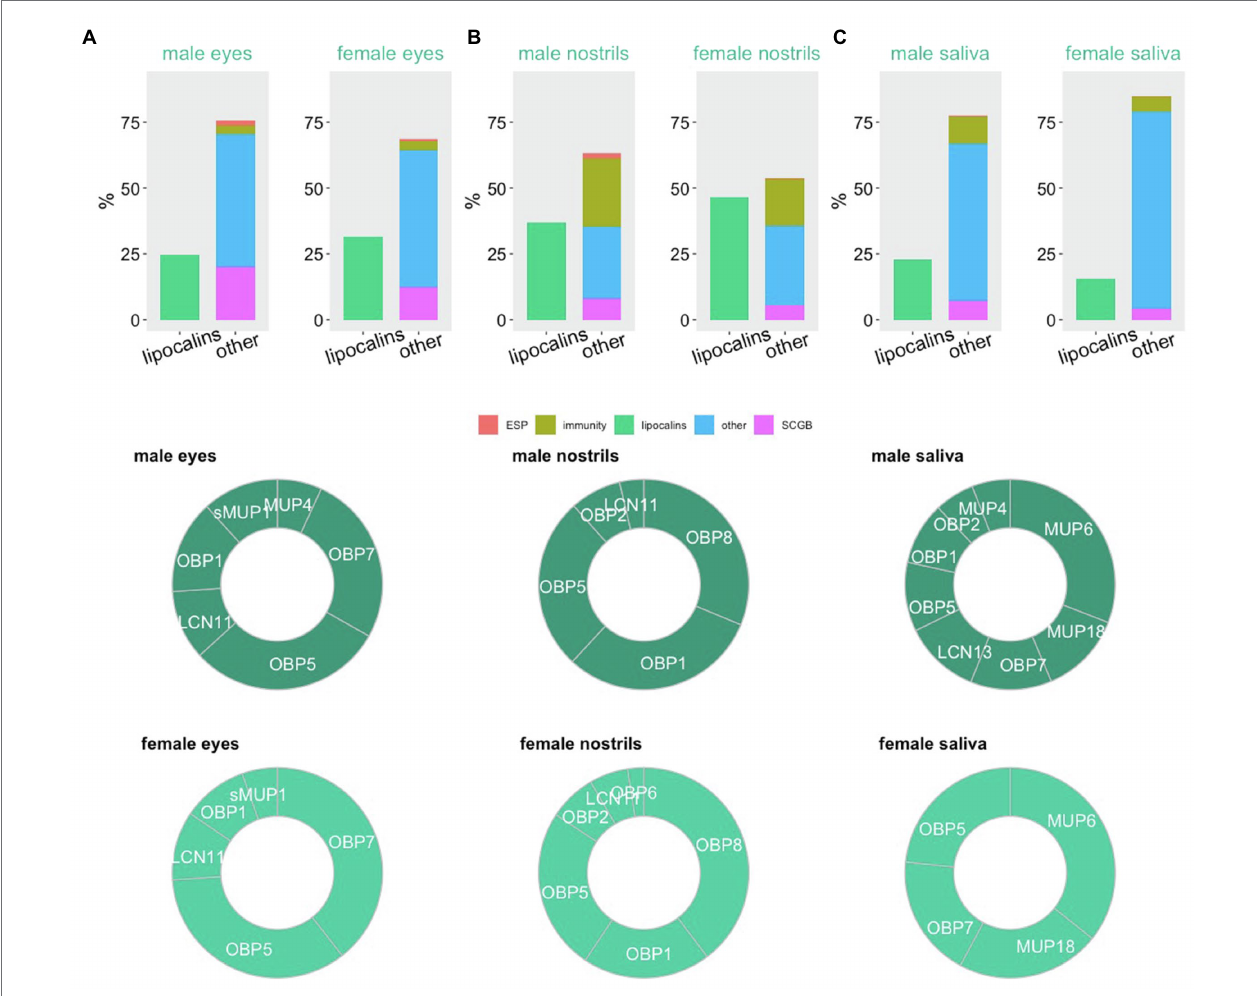
FIGURE 2 | Proteomic signatures in major orofacial secretions of the house mouse. Estimation of protein abundances is represented as a fraction (%) of all proteins in male and female eyes (A) , nostrils (B) , and oral cavity (C) . We have extracted this data from our previously published studies with publically available data. Proxy for functions (exocrine-gland secreted peptides – ESP, immunity, lipocalins, secretoglobins – SCGB) is based on public gene ontology